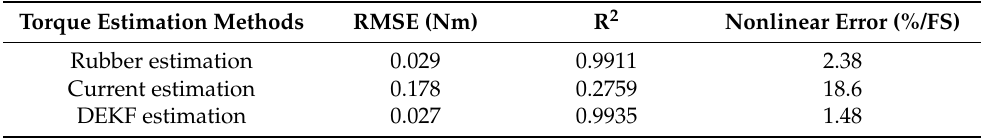
Table 5. The estimation accuracy of the three torque estimation methods. Torque Estimation